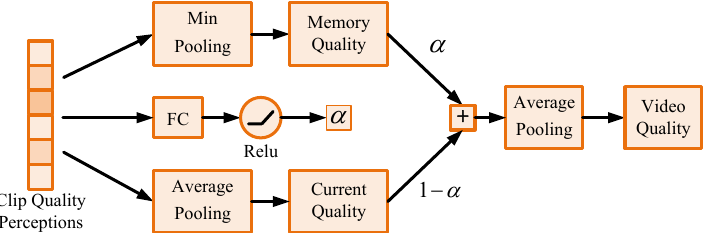
Figure 5. Adaptive Perception Score Generation. Parameter α is generated by clip-level quality perception scores with a fully connected layer and a nonlinear